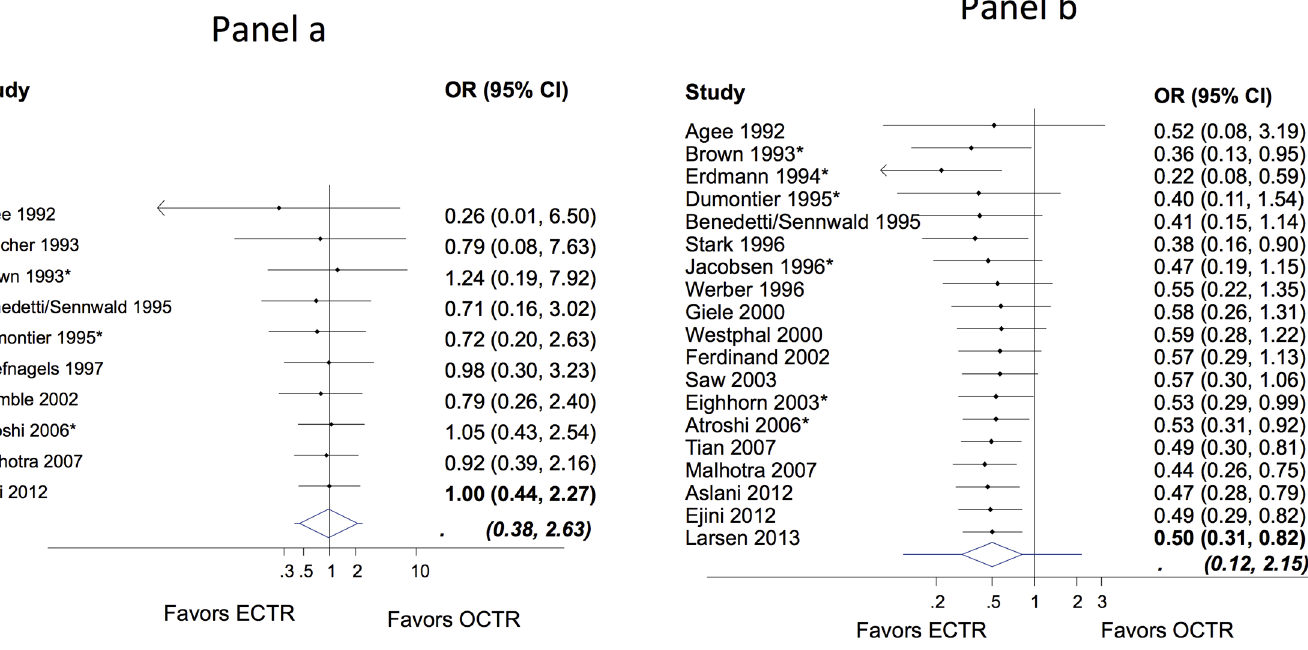
Fig 3. Cumulative odds ratios (OR) and 95% confidence interval (CI) for minor (panel a) and major (panel b) complications. The extended lines outside the diamond in the final meta-analytic summary shows the 95% prediction intervals. Asterisk indicates that the study has used a two-portal ECTR.